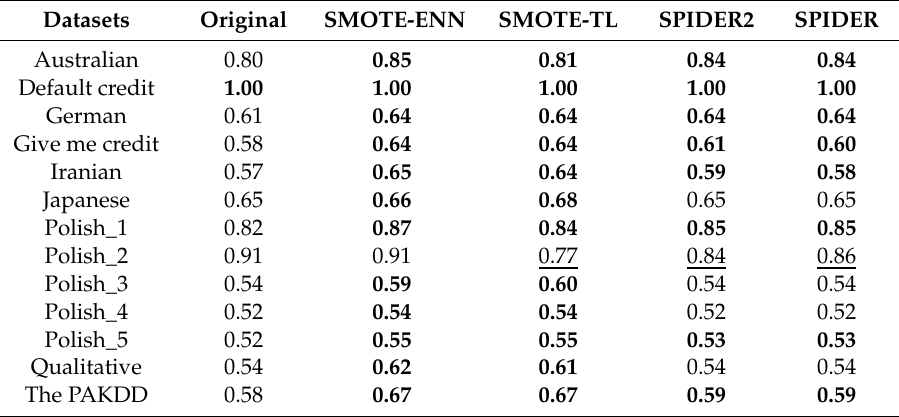
Table 20. AUC for SNDAM classifier after hybrid